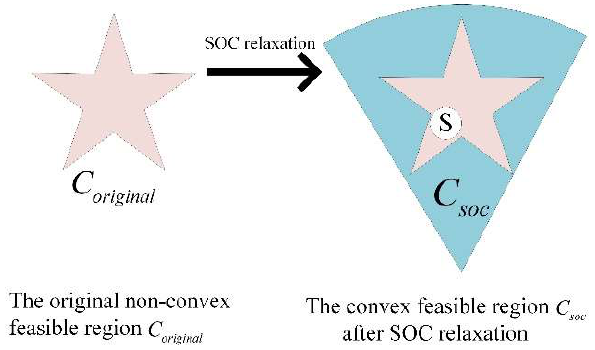
Figure 3. Schematic diagram of SOCR.